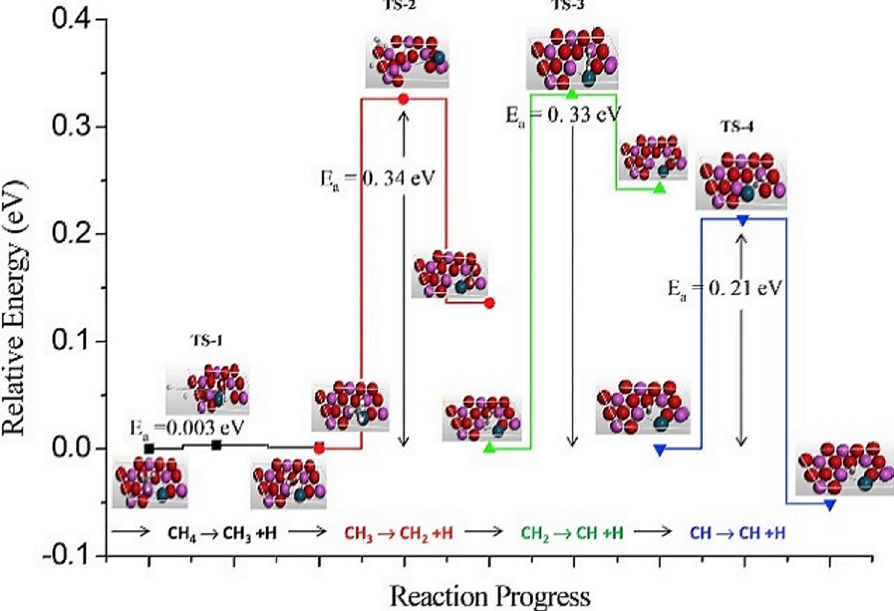
means the adsorption and cracking processes are able to be treated simultaneously.